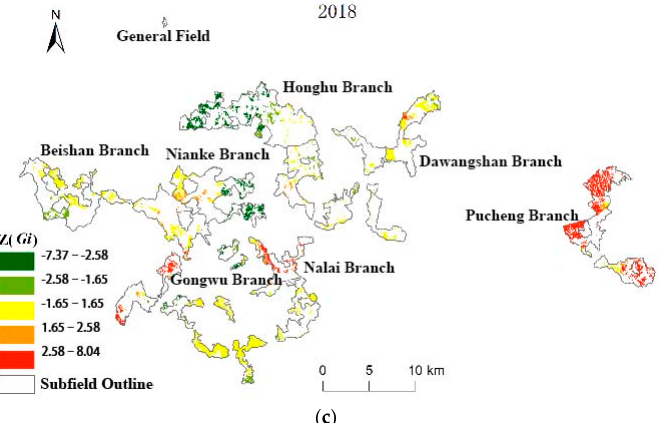
Figure 10. The distribution of cold–hot spots of soil conservation for PM plantations in Paiyangshan Forest Farm from 2009 to 2018 is presented in this figure. The aggregation index degree parameter is denoted by Z(Gi*). The color red represents hot spot regions, orange represents sub-hot spot re- gions, yellow indicates insigni fi cant regions, dark green denotes cold spot regions, and light green indicates sub-cold spot regions. Panel ( a ) displays the distribution of cold–hot spots of soil conser- vation in 2009; panel ( b ) shows the distribution in 2013; and panel ( c ) depicts the distribution in 2018.